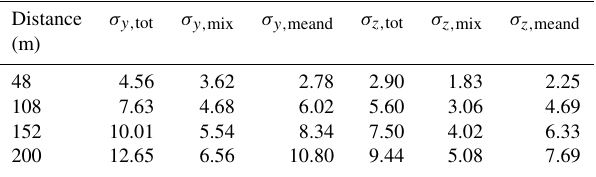
Table 2. Dispersion coefficients σ (in m), obtained by using the definitions presented in Sect. 3.4, for the plume emitted at